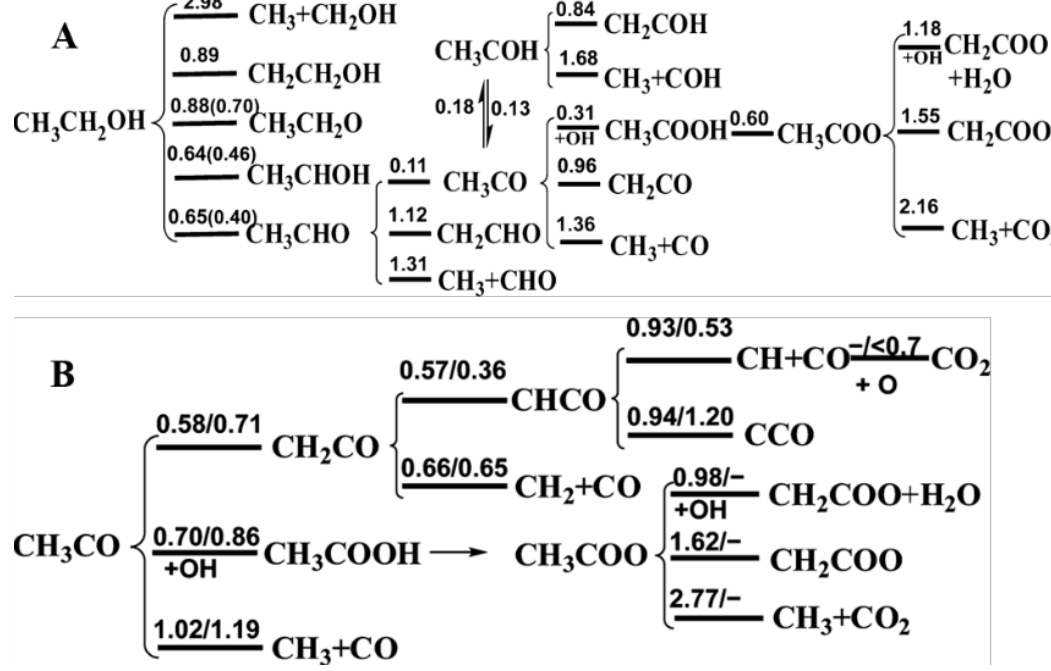
Figure 7. Calculated reaction network and reaction barriers (units, eV) for ethanol oxidation ( A ) on Pt (111) and acetyl oxidation ( B ) on Pt (211) (data on the left) and Pt (100) (data on the right). Reprinted and adapted with permission from Ref. [43]. Copyright 2008, American Chemical